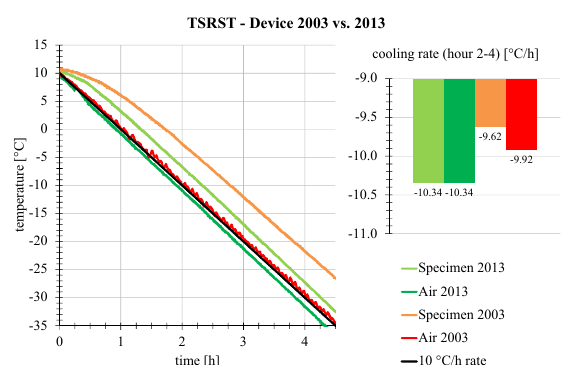
Figure 3. Air and specimen core temperature in a TSRST for 2003 and 2013 device.